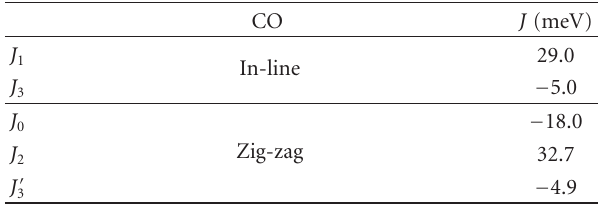
Table 9: The e ff ective exchange coupling constants calculated from the LDA+ U total energies for the in-line and zig-zag CO models [245].